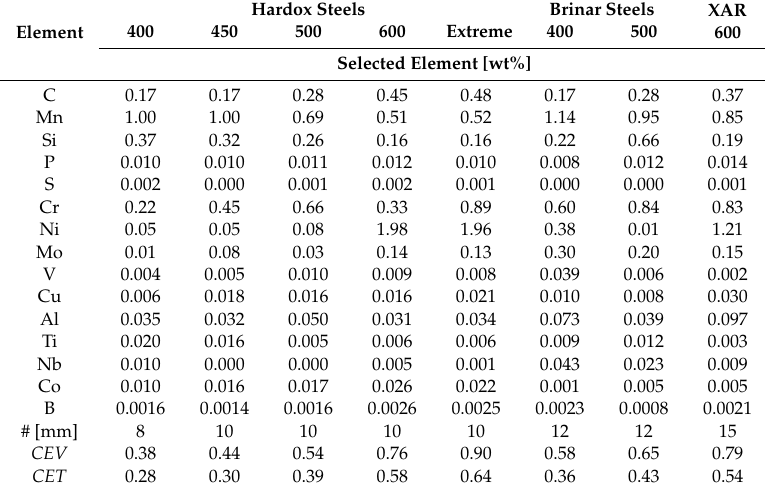
Table 3. Real chemical compositions and carbon equivalent values calculated on their grounds for sheet metal 8–15 mm thick of selected low-alloyed steels [18,24].